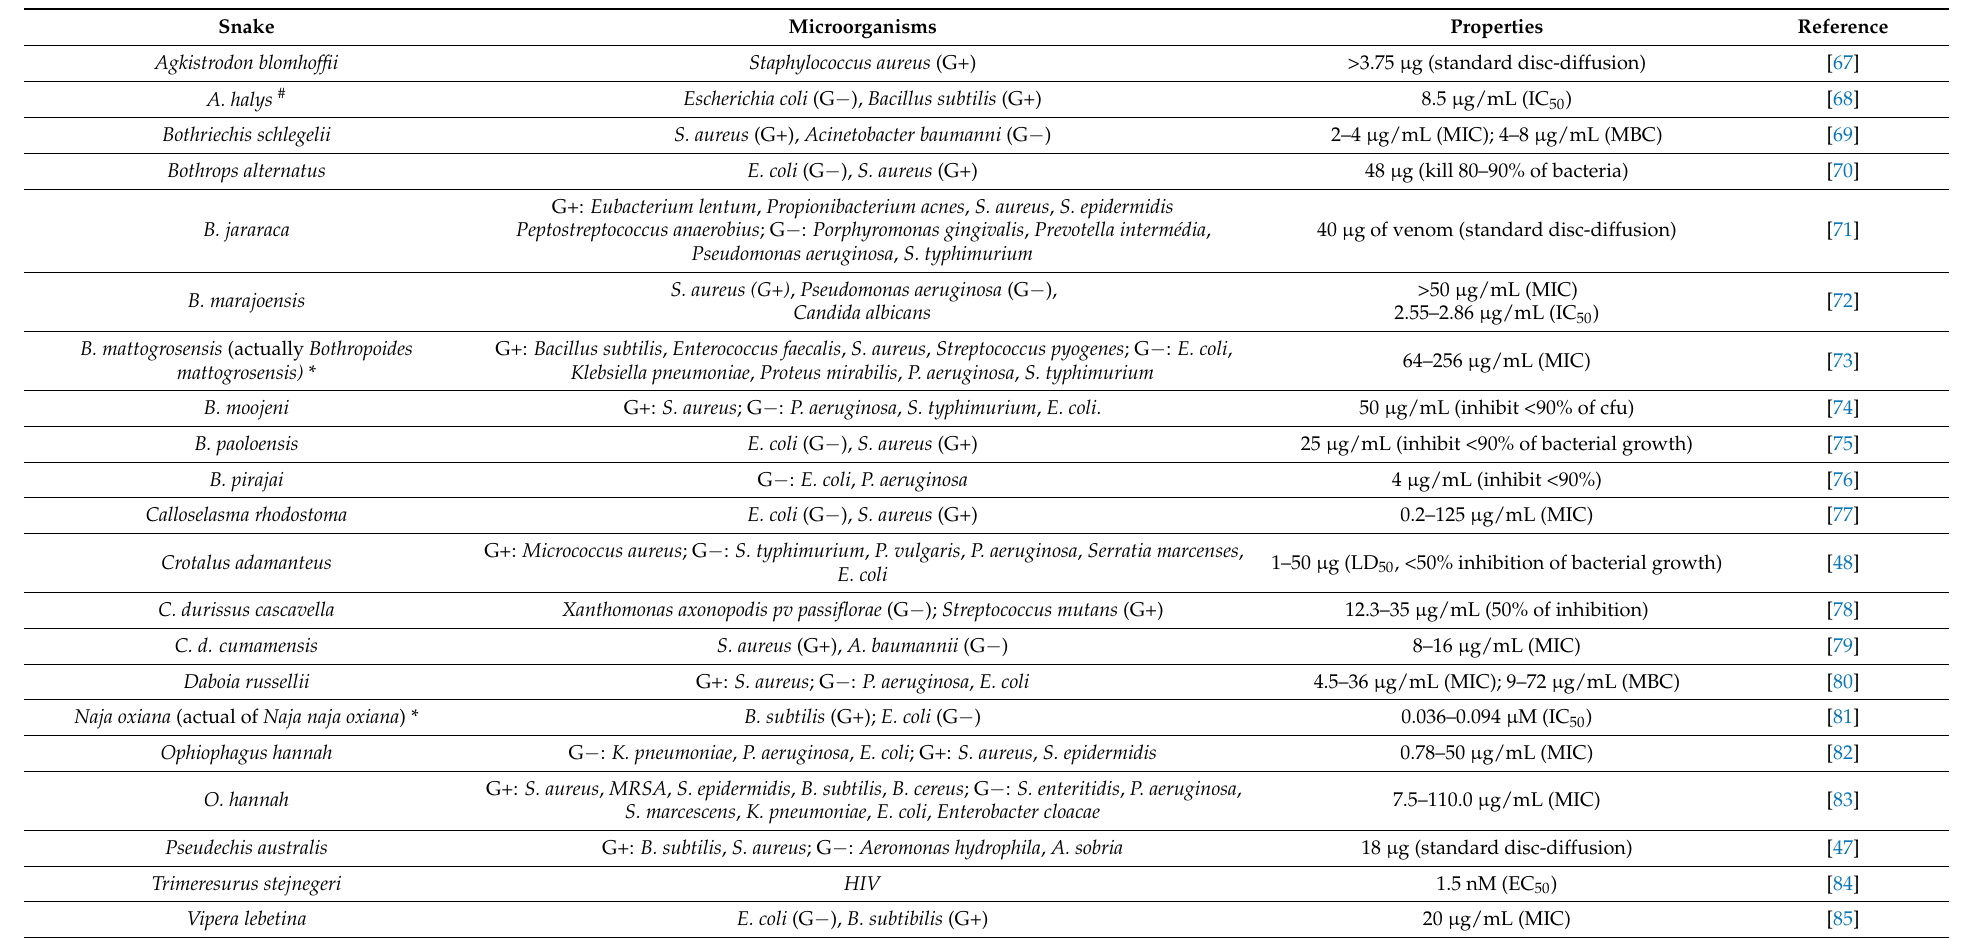
Table 2. Antimicrobial activity of snake-venom L-amino oxidase